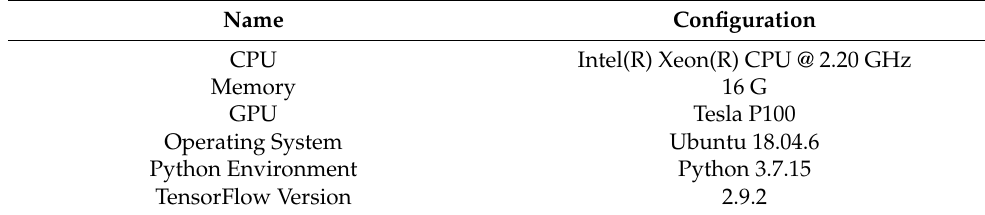
Table 1. Experimental configuration.